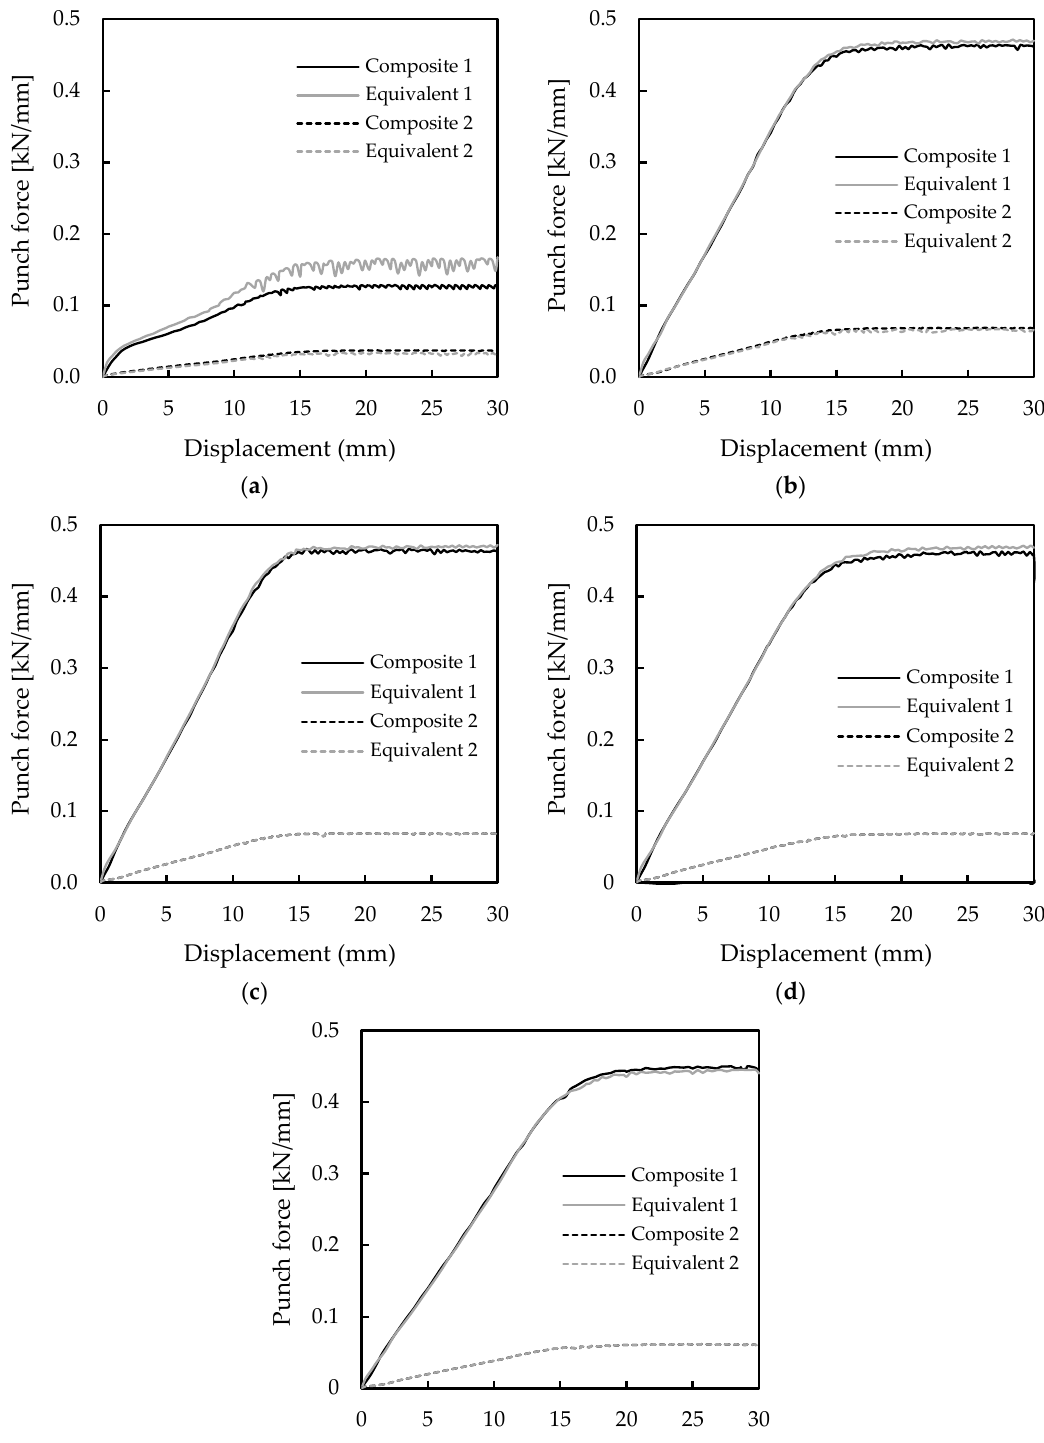
Figure 10. Evolution of the punch force, normalized with the blank width, vs. its displacement during the deep drawing process of the U-channel for the composites 1 and 2, and their corresponding equivalent materials: ( a ) case A; ( b ) case B; ( c ) case C; ( d ) case D; ( e ) case E.